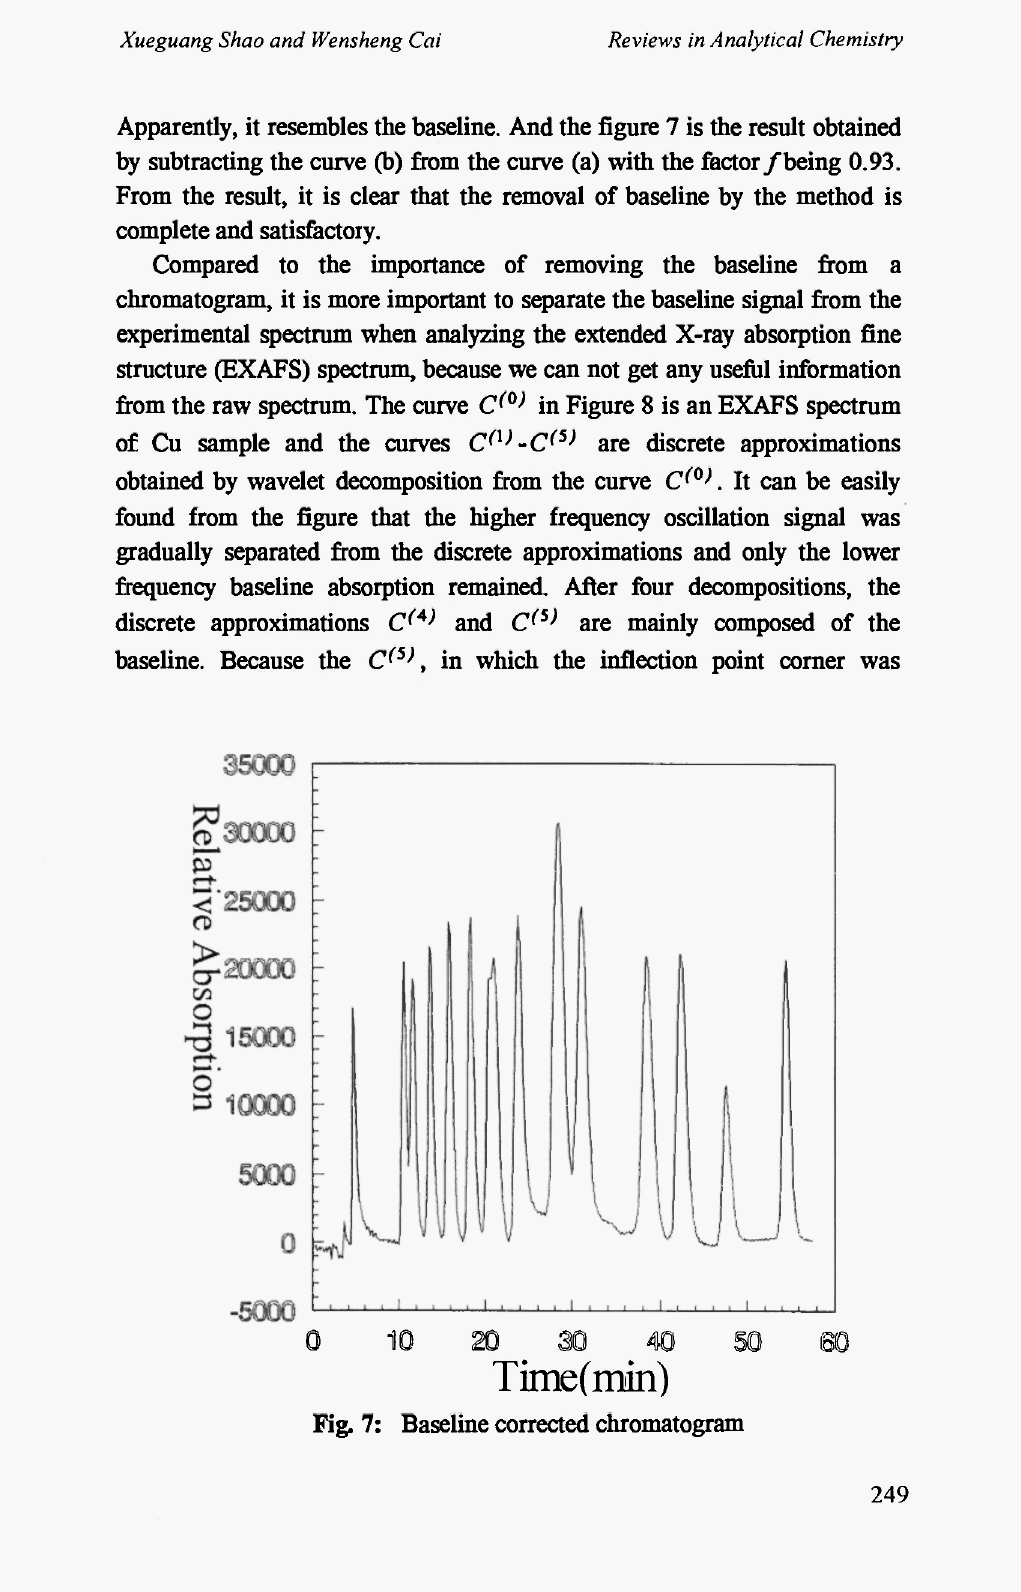
Fig. 7: Baseline corrected